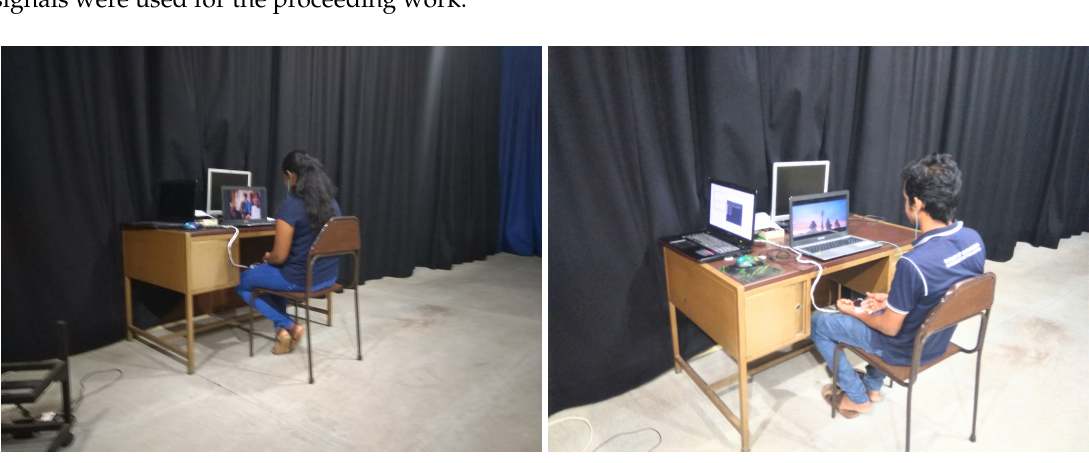
Figure 3. Experiment